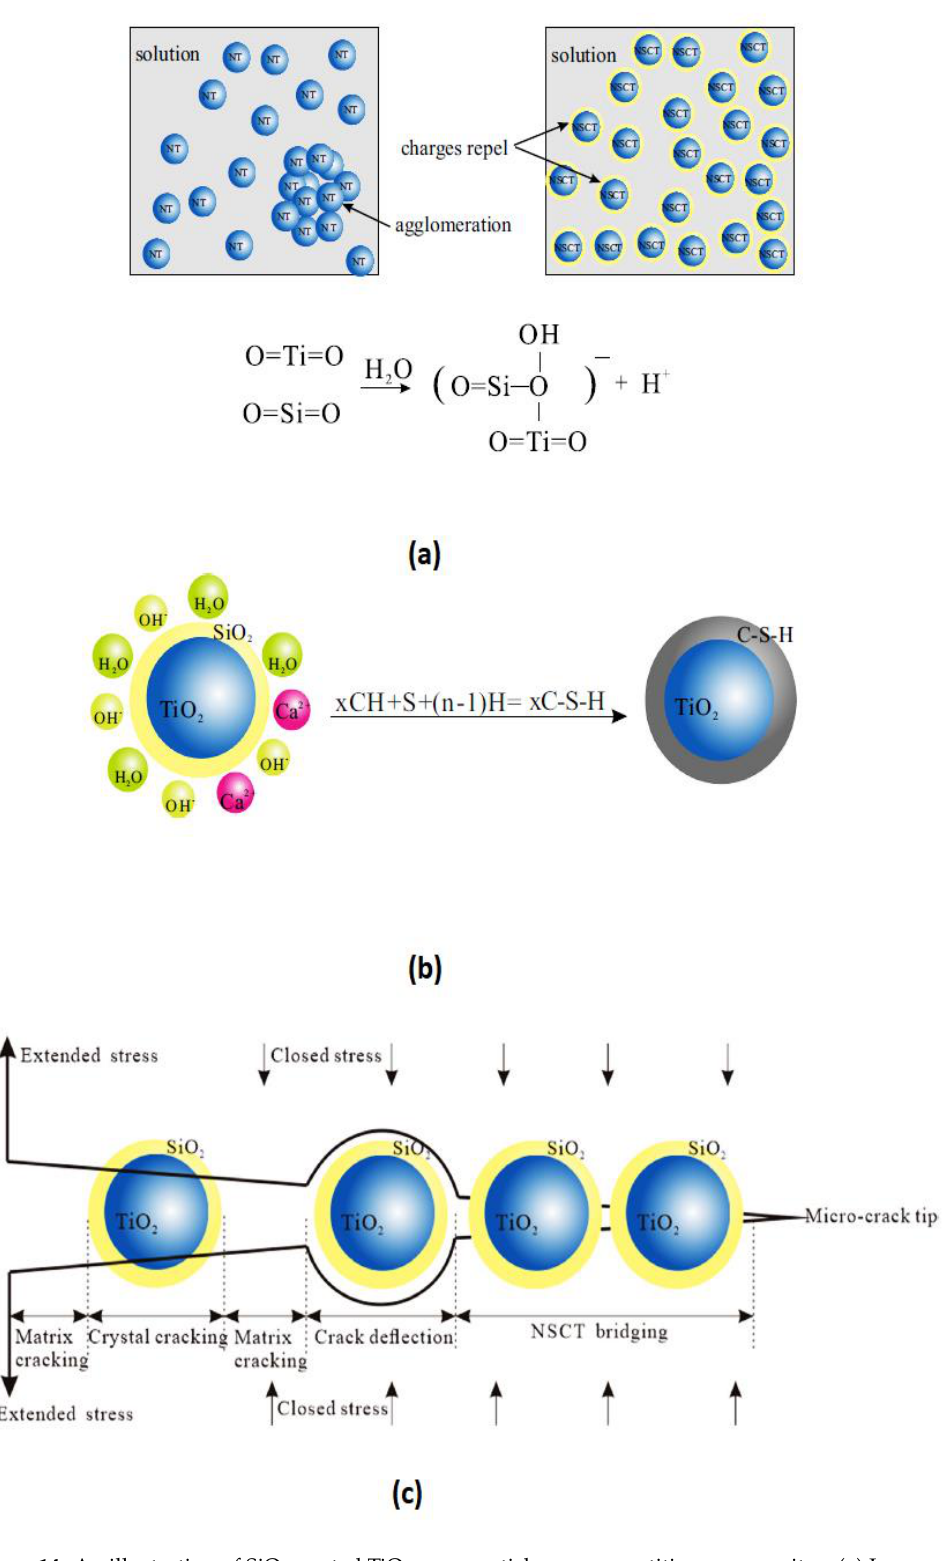
Figure 14. An illustration of SiO 2 -coated TiO 2 nanoparticles on cementitious composites. ( a ) Improved dispersion due to repelling charges. ( b ) Pazzolanic activity of SiO 2 -coated TiO 2 . ( c ) Nanocore effect to control microcrack propagation [149]. (Note: NSCT is Nano SiO 2 -coated TiO 2 ). Various numbers of parameters would affect the impact of nano-TiO 2 on the compressive strength of cementitious composites including the nano-TiO 2 dosage [130,131,152 – 154], nano-TiO 2